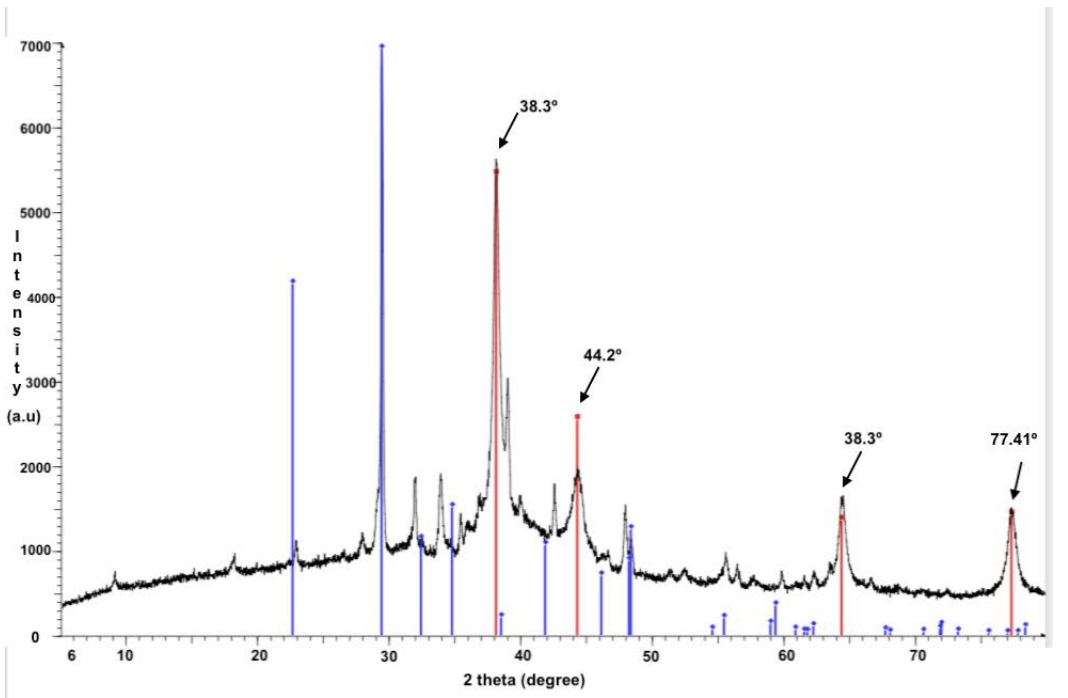
Figure 2. X-ray diffraction pattern of the sample containing L -Cys-AgNPs showing peaks at 38.3°, 44.2°, 64.5°, and 73.41°, associated with the presence of metallic silver.